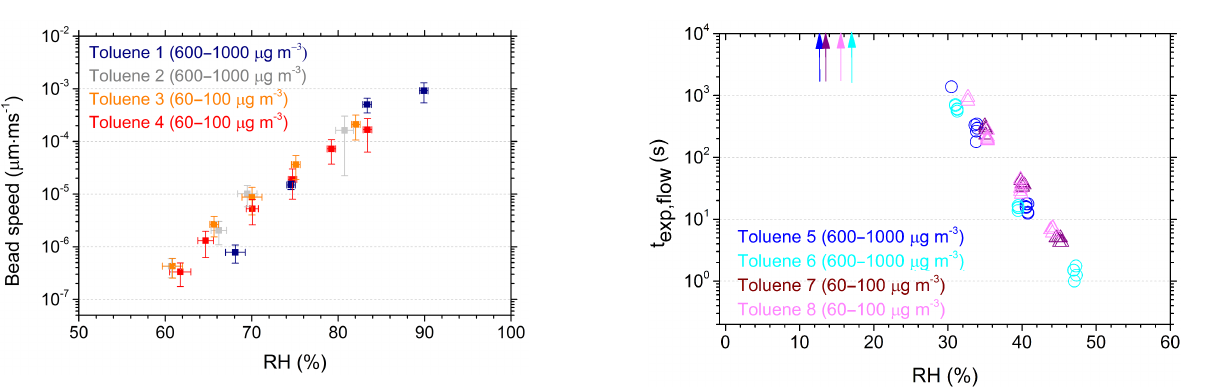
Figure 4. Results from poke-flow experiments. τ exp, flow , where the diameter of hole has decreased to 50% of its initial size, measured for the different samples (toluene 5, 6, 7, and 8, see Table 1). The arrows indicate particles shattered at the given